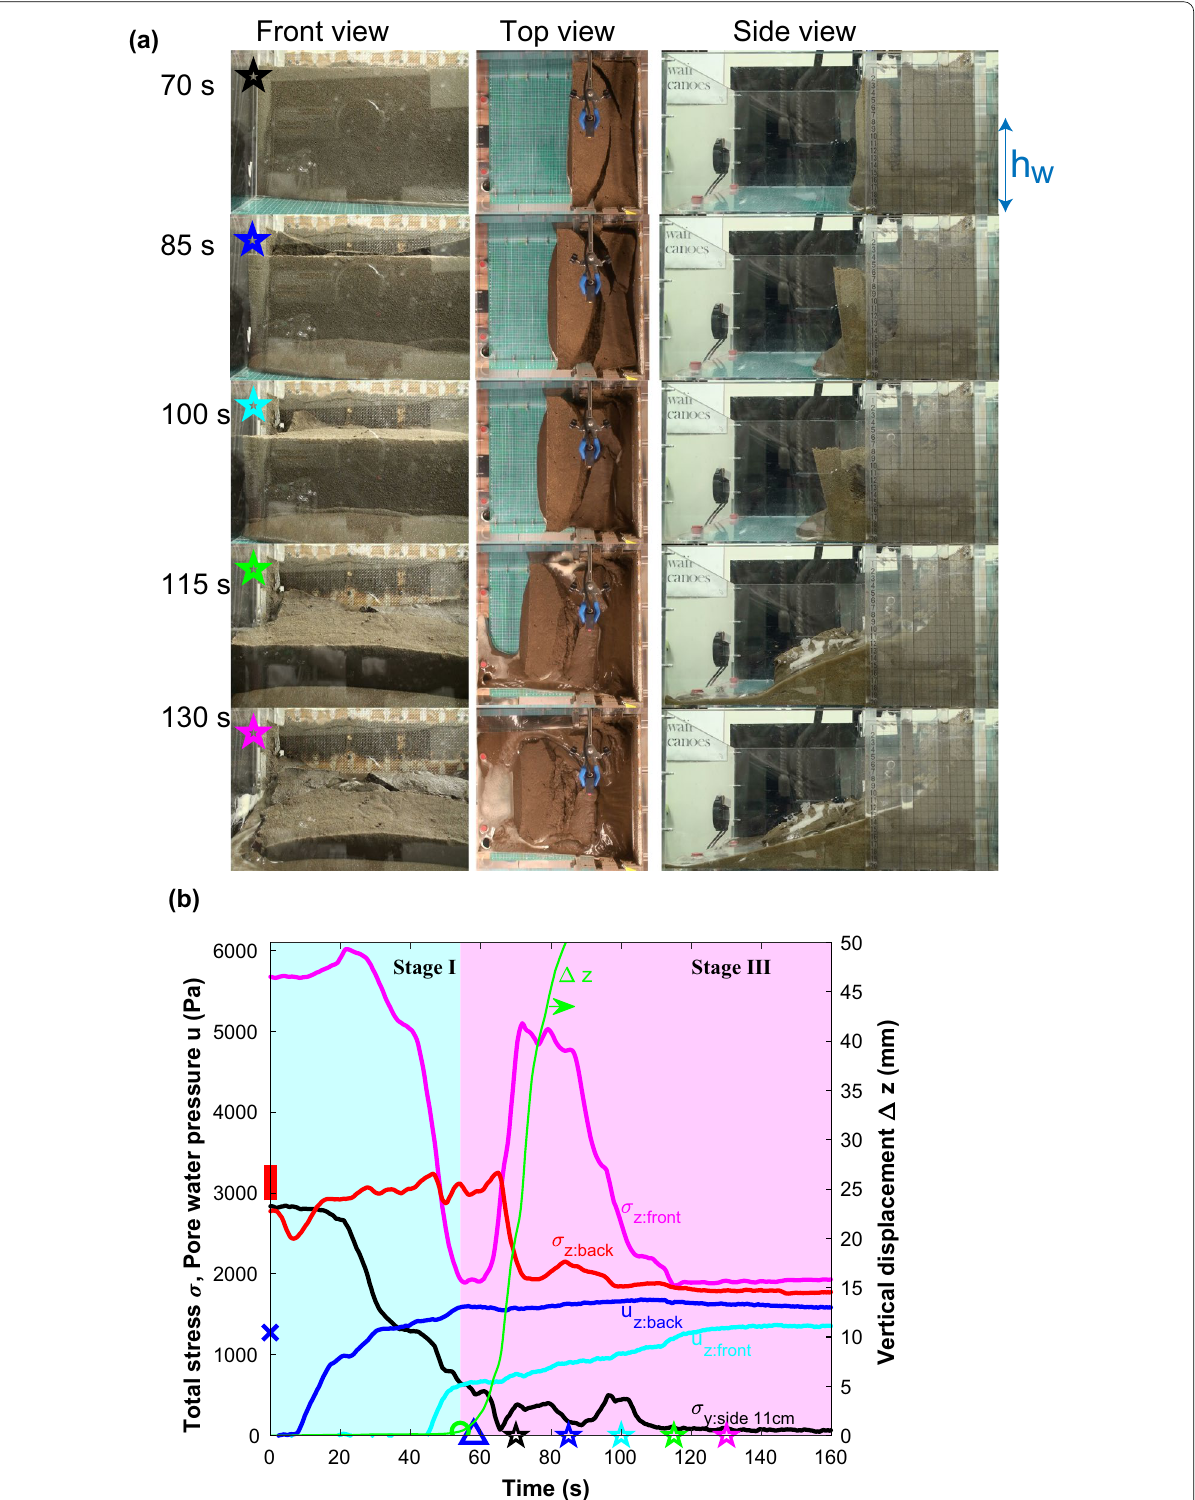
Fig. 7 Results of the h w = 13 cm (run 12, H = 20 cm, h w / H = 0.65 ) case in which a slide is triggered followed by flooding (Additional file 3: Movie S3). a Images, and b time-series data of the sensor measurements (5-point running averaged). The T slide = 54 s (green (cid:31) ) and T seep = 58 s (blue (cid:31) ) are nearly simultaneous. See Fig. 4 legend for explanations of the red bar and blue × on the left